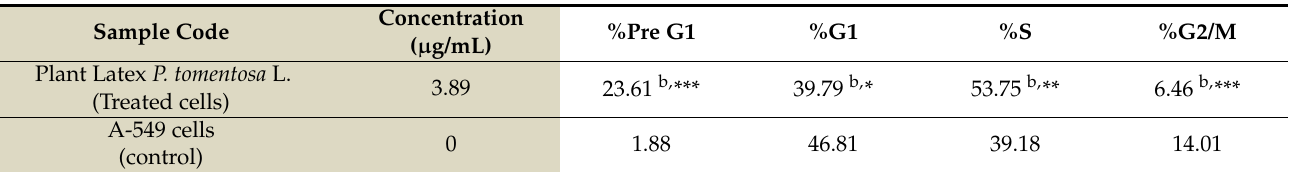
Table 1. Effect of the plant latex of P. tomentosa L. compared to the control treatments on the phases of the cell cycle of the lung cancer cell line (A-549) a .